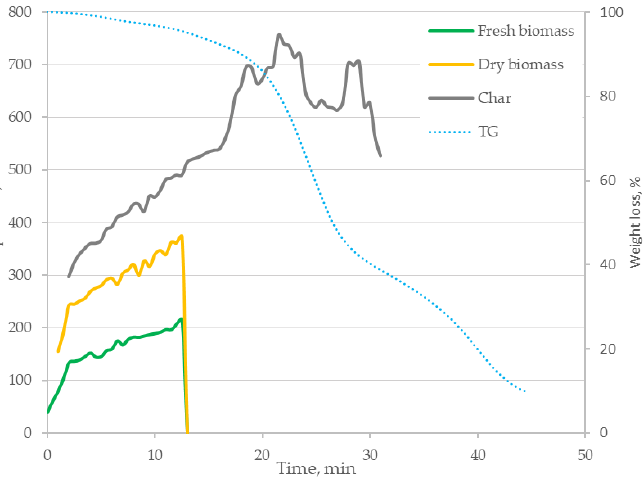
Figure 10. Change in the temperature of fresh biomass, dry biomass and char — sample 25K75J.